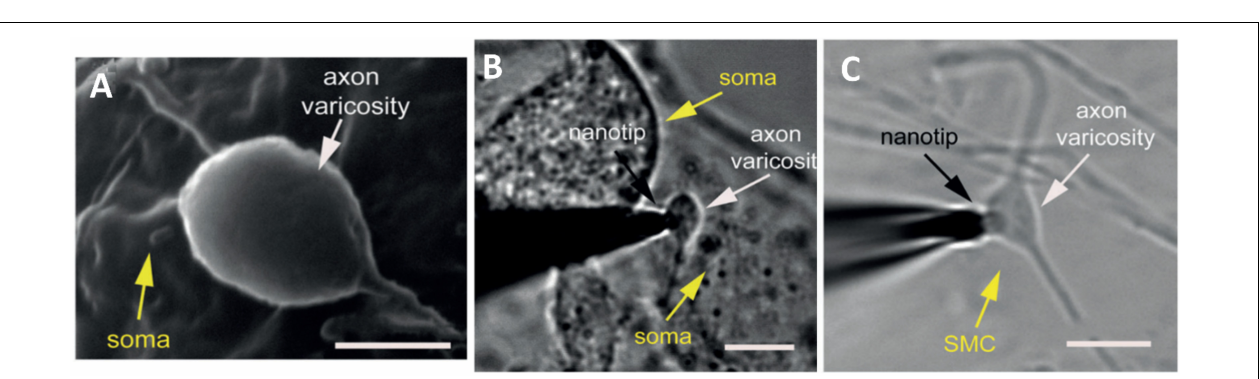
FIGURE 6 | Measurement of octopamine release from Drosophila melanogaster larvae by amperometry. (A) Schematic depicting muscles from the body wall, including muscles 12 and 13, which contain type 2 octopaminergic varicosities. (B) Dissection of the third instar larva revealing the body muscle wall. (C) Position of microelectrode on type 2 varicosities in muscle 13; (D) Same view as panel (C) but under red light to visualize mCherry in octopaminergic terminals, and the white ring indicates the location of the electrode. (E) Different amperometric peaks of the octopamine released from varicosity stimulated by blue light. (E1) Two overlapping peaks, (E2) plateau complex event, and (E3) single event. This Figure was reproduced from Majdi et al. (2015) under the creative commons license.